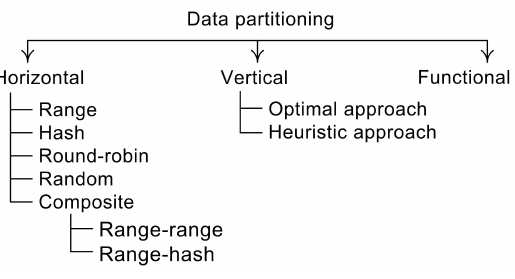
Fig. 3 Data partitioning methods.